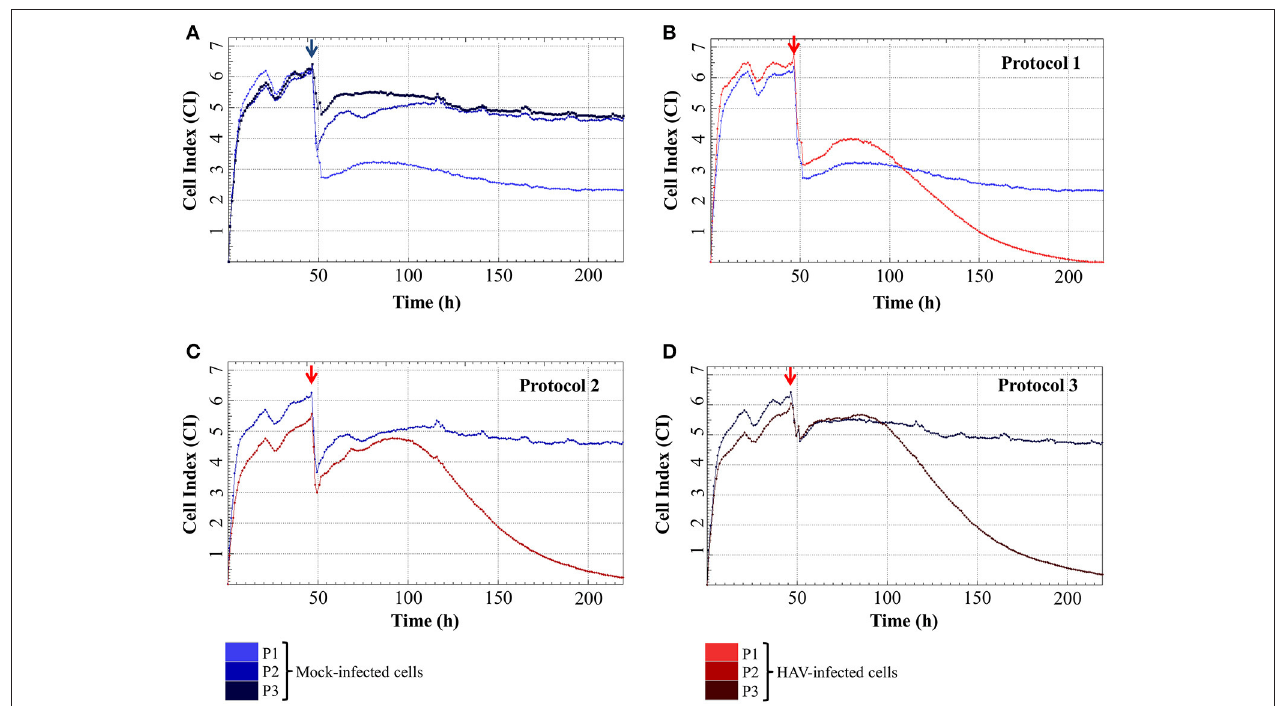
FIGURE 3 | Real-time impedance analysis of mock- and HAV-infected FRhK-4 cells according to the infection protocol. (A) Cell Index values of mock-infected cells according to the infection protocol used. (B–D) Cellular impedance in mock (blue) and HAV-infected cells (red) using Protocol 1 (B) , Protocol 2 (C), and Protocol 3 (D) . The red arrows indicate the time after which HAV was added on sub-confluent monolayers of FRhK-4 cells.